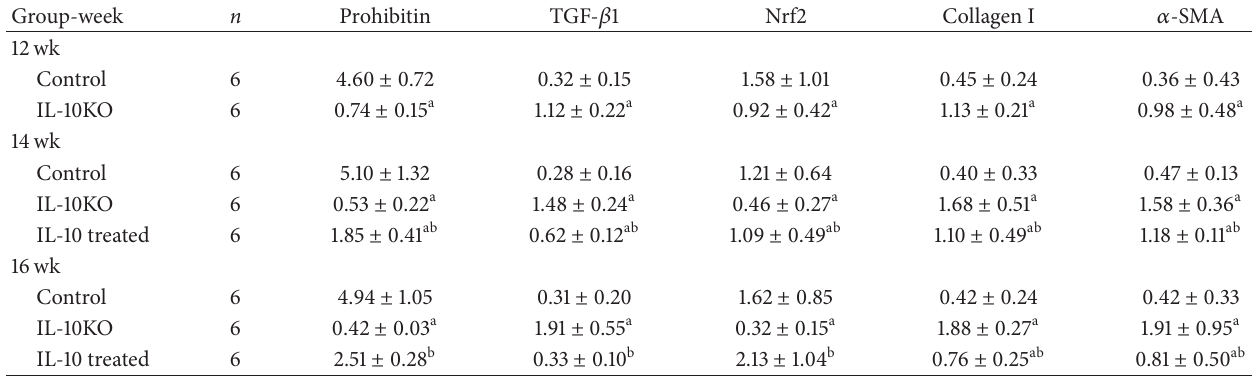
Table 2: Gene expression of prohibitin, Nrf2, collagen I, 𝛼 -SMA, and TGF- 𝛽 1 (𝑥 ± 𝑠, % ) .